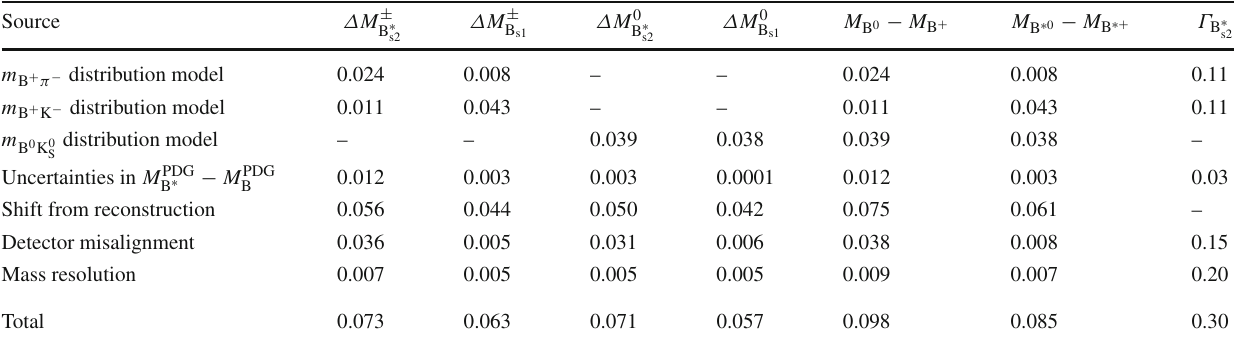
width is measured only in the B + K − s2